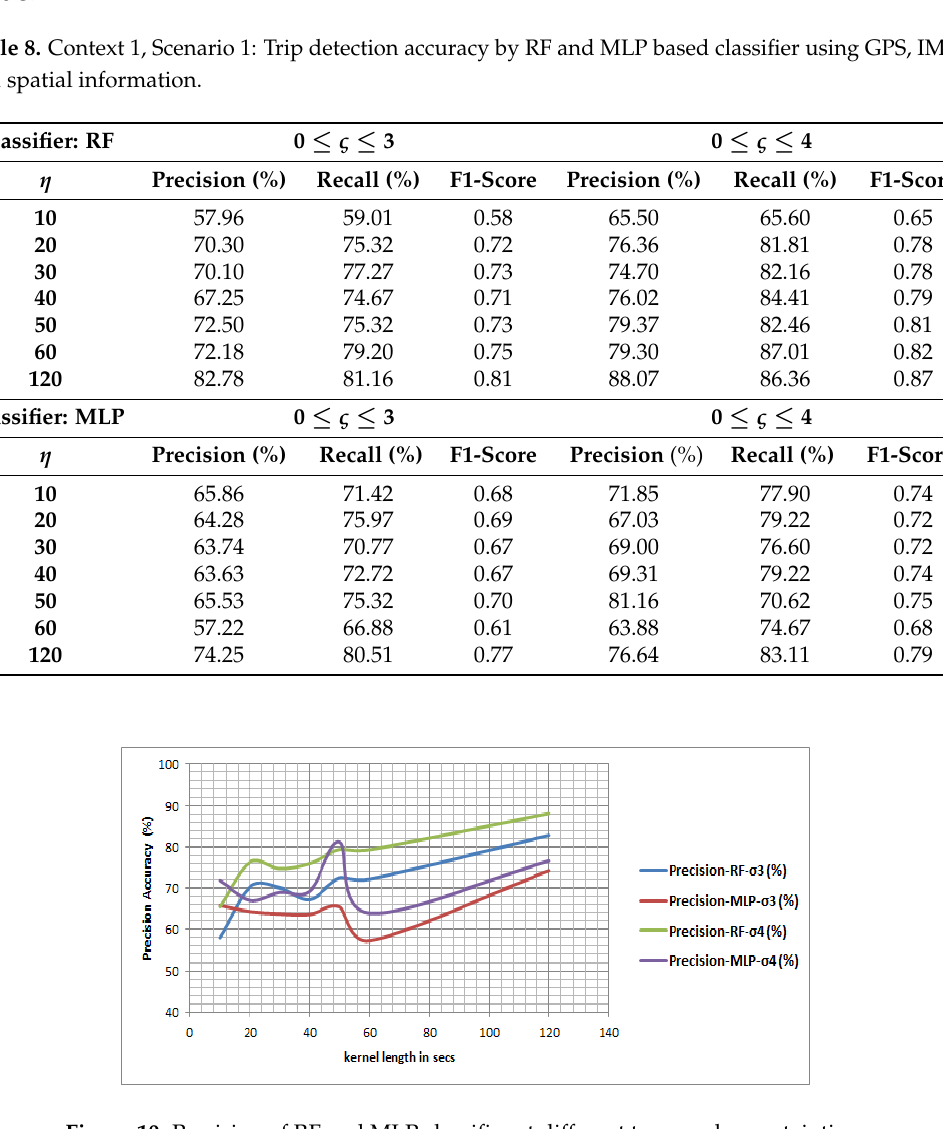
Figure 10. Precision of RF and MLP classifier at different temporal